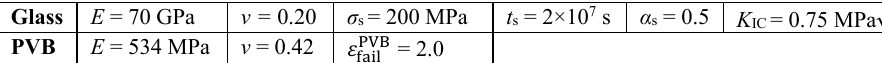
Table 2. Input parameters for the glass and PVB models.